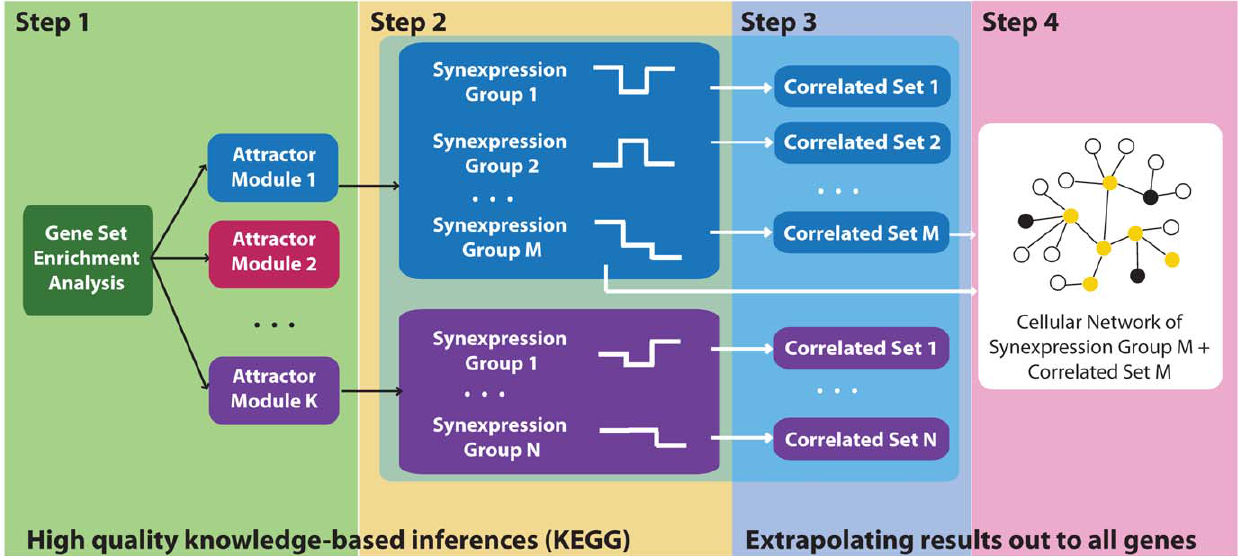
Figure 2. The ANOVA-based step of attract —a novel gene set enrichment implementation. Each gene is assigned an F-statistic where consistent cell-type specific changes are up-weighted. Pathways that have distributions of F-statistics distinct from the global distribution are flagged as significantly enriched for cell-type specific expression changes.